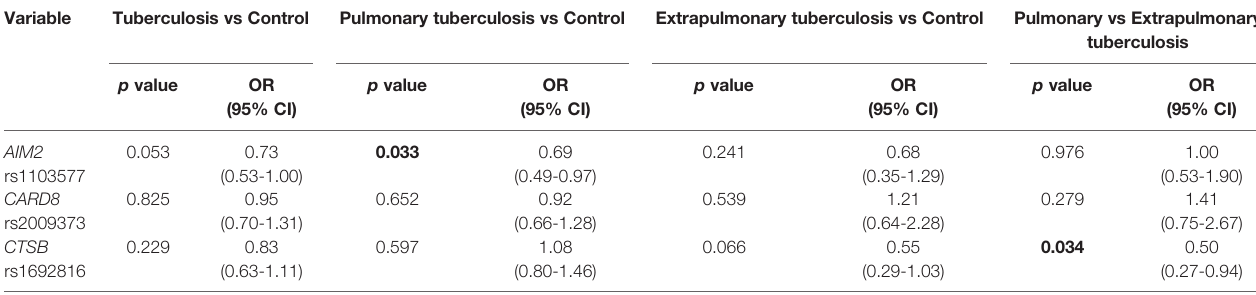
TABLE 5 | Multivariate logistic regression analysis for variables sex and age, including three in fl ammasomes genes in the studied groups. Variable Tuberculosis vs Control